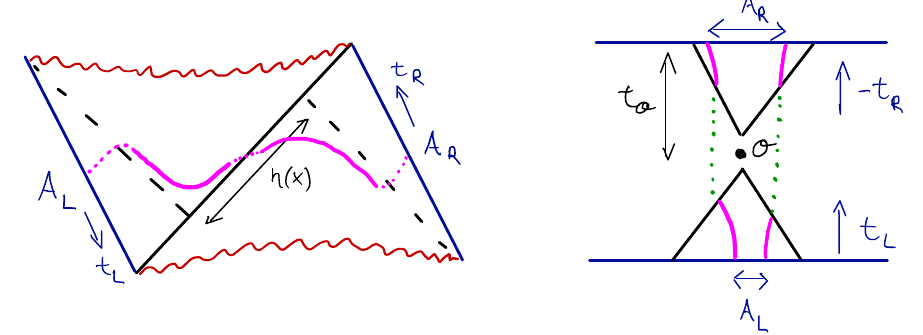
Figure 8 . Left: the Penrose diagram of the shockwave spacetime is obtained by gluing together two black branes along their u = 0 horizon (solid black line) with the shift in the space dependent shift in the v coordinates equalling h ( x ). This is indicated by the mismatch of the v L;R horizons drawn by dashed black lines. With magenta we sketch the HRT surface interpolating between the regions A L and A R , the solid portions of the line are indicating the parts of the HRT surface captured by the membrane theory, while the dotted portions are discarded in the e(cid:11)ective theory. Right: the membrane theory description of the entanglement entropy of HRT surfaces map onto the membranes living in the two cones, whose faces are glued together as indicated by the dotted green lines. The tips of the cones are displaced from